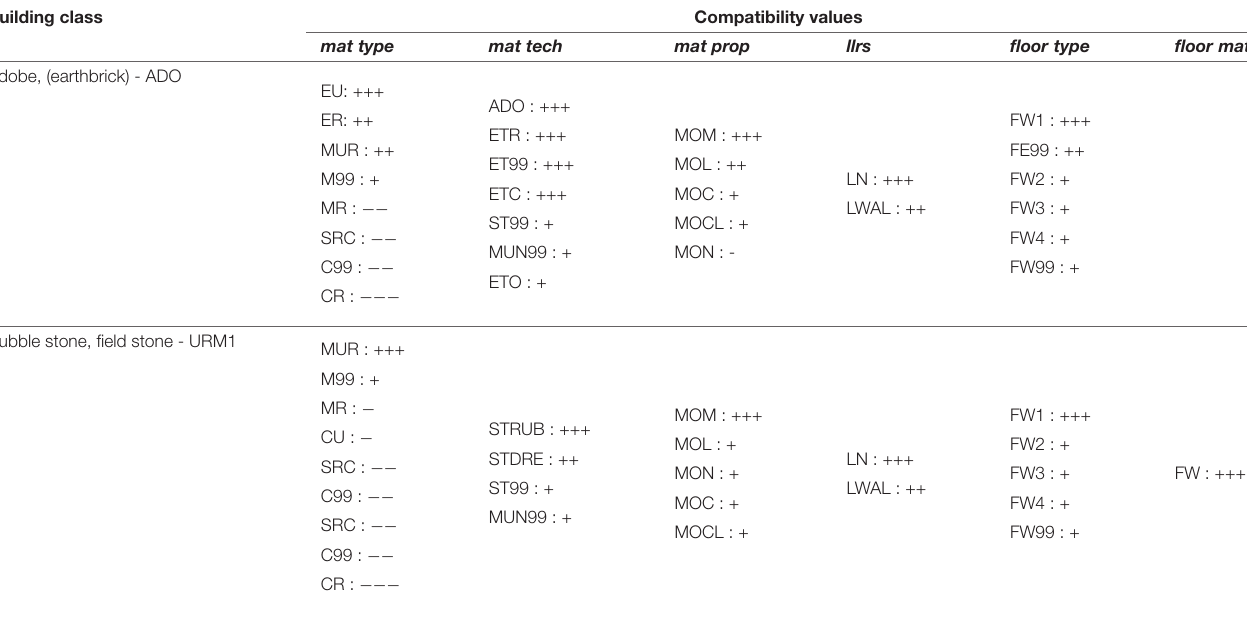
TABLE 2 | Class descriptions for two example building typologies from EMS-98, in terms of fuzzy compatibility levels. Building